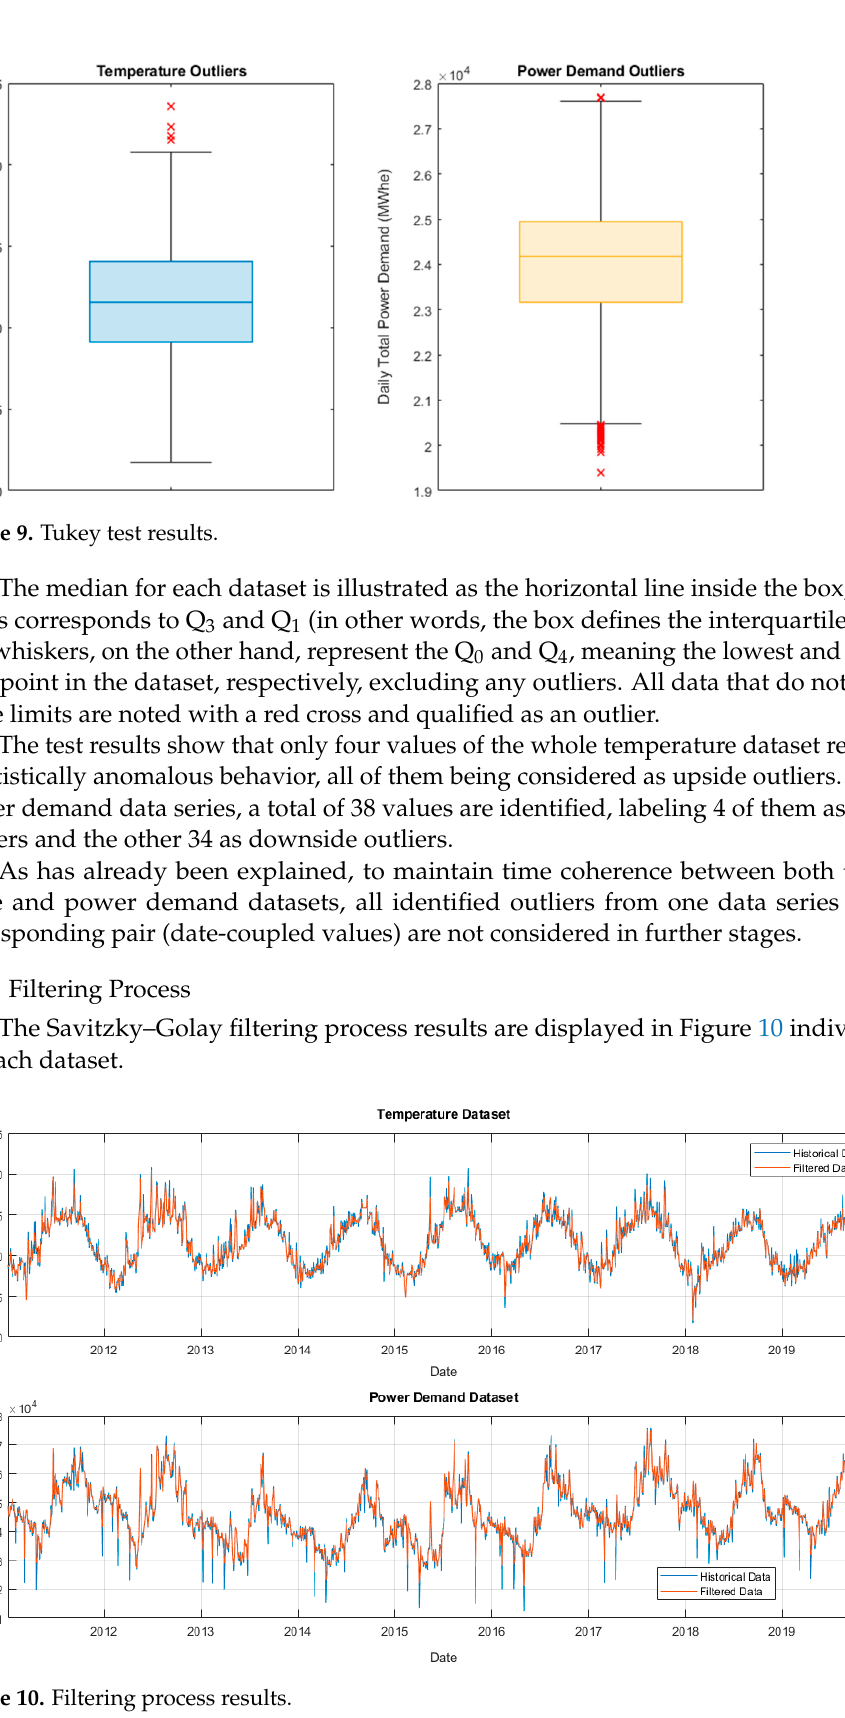
Figure 10. Filtering process results.